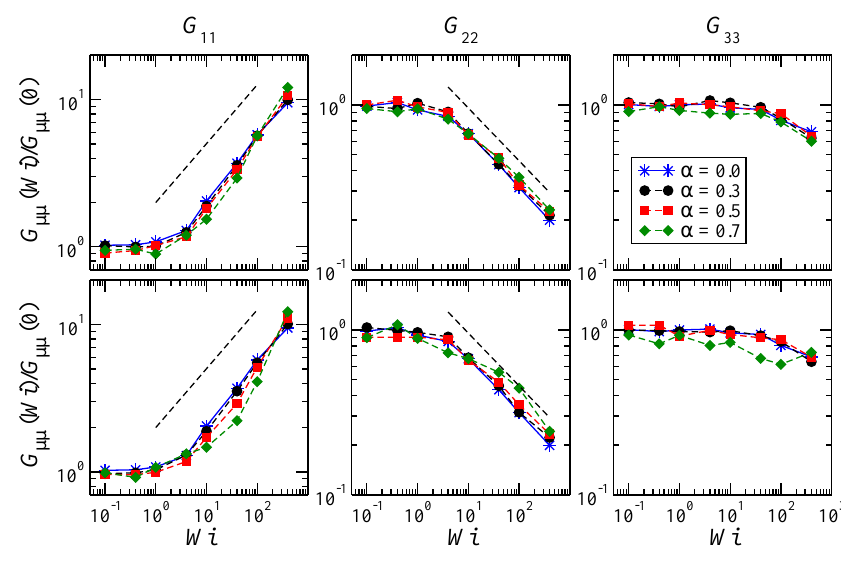
Figure 5. Diagonal components of the (average) gyration tensor of an SBC with f = 18, N pol = 40, λ = 1.0 (top row) and λ = 1.1 (bottom row). For athermal stars, the scalings G 11 ∼ Wi 0.4 and G 22 ∼ Wi − 0.32 are found at high Wi .